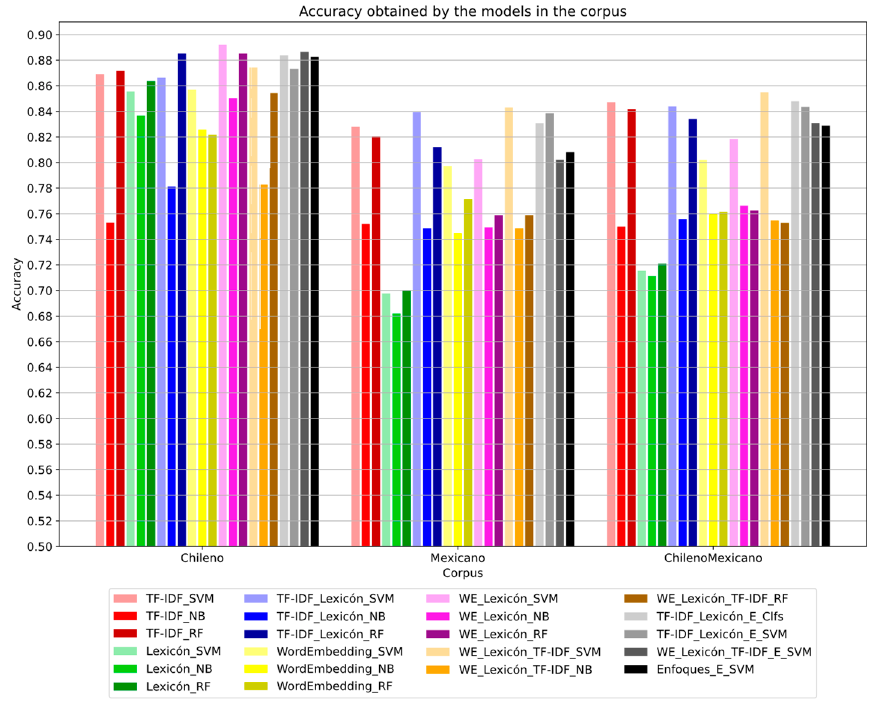
Figure 16. Comparison of Accuracy obtained by the models. Table 8. Hybrid models outperforming the best non-Lexicon model in the Chilean corpus. Model